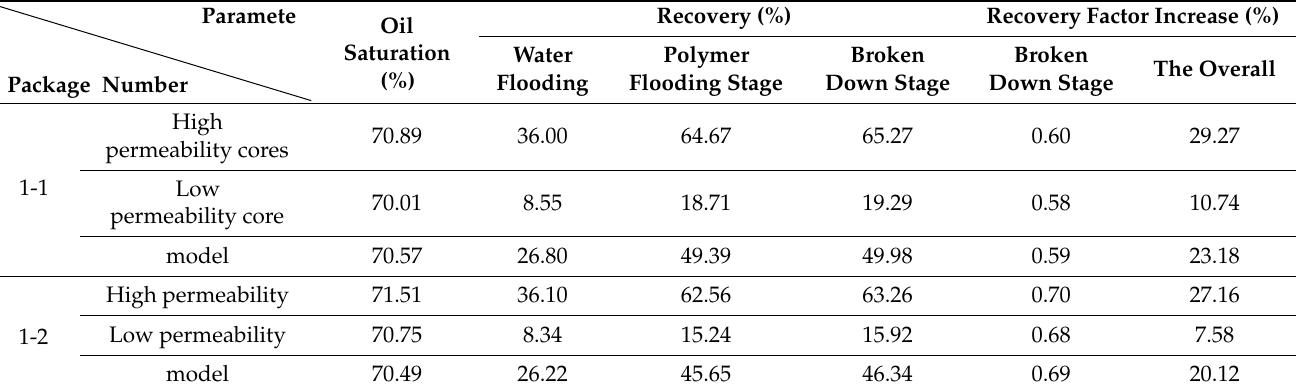
Table 1. Experimental data of recovery